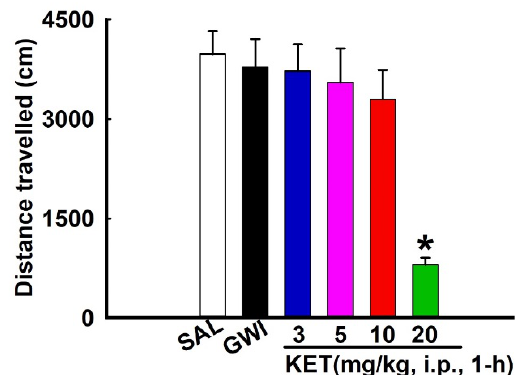
Figure 3. Dose-dependent effect of ketamine (KET) on the OFT in a DFP rat model for GWI. Baseline locomotor activity in DFP-treated rats (GWI) was not different compared to saline-treated, age-matched control rats (SAL). KET (3-, 5-, 10 mg/kg, i.p.) exhibited no significant differences in the distance traveled on the OFT compared to saline-treated GWI rats when tested at 1 h post-injection. KET (20 mg/kg, i.p., 1-h) significantly reduced the distance travelled on an OFT compared to GWI rats (Data expressed as mean ± SEM, * p < 0.05, One-way ANOVA, Tukey test, n = 5 rats/group).